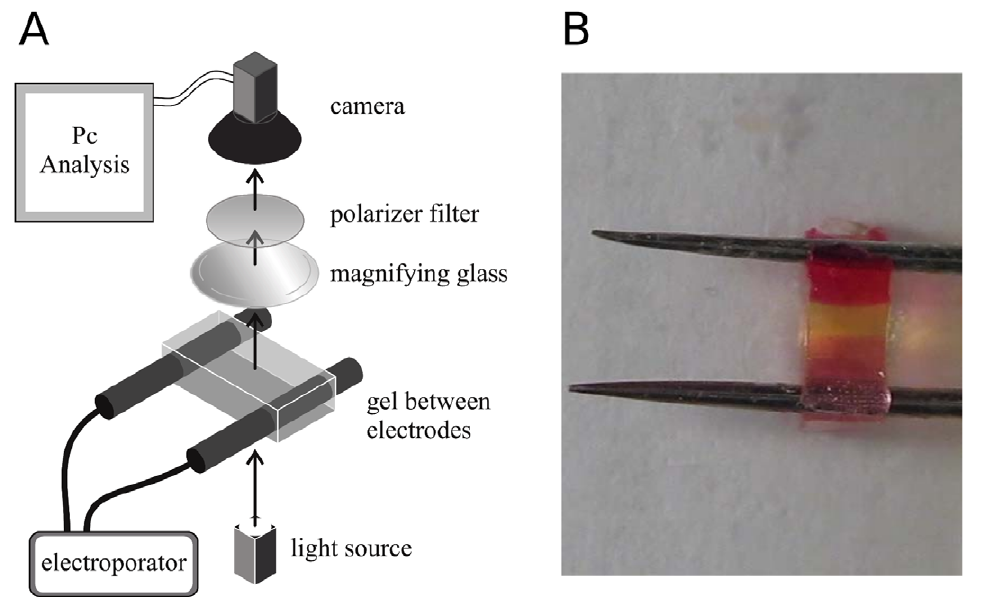
Figure 1. Experimental setup. a) The electroporator is conected to the electrodes placed in the gel. Images of the process during the ECT are collected through an optic system by a videocamera and then analyzed by specific software. b) Detail of the electrodes placed in the gel revealing the